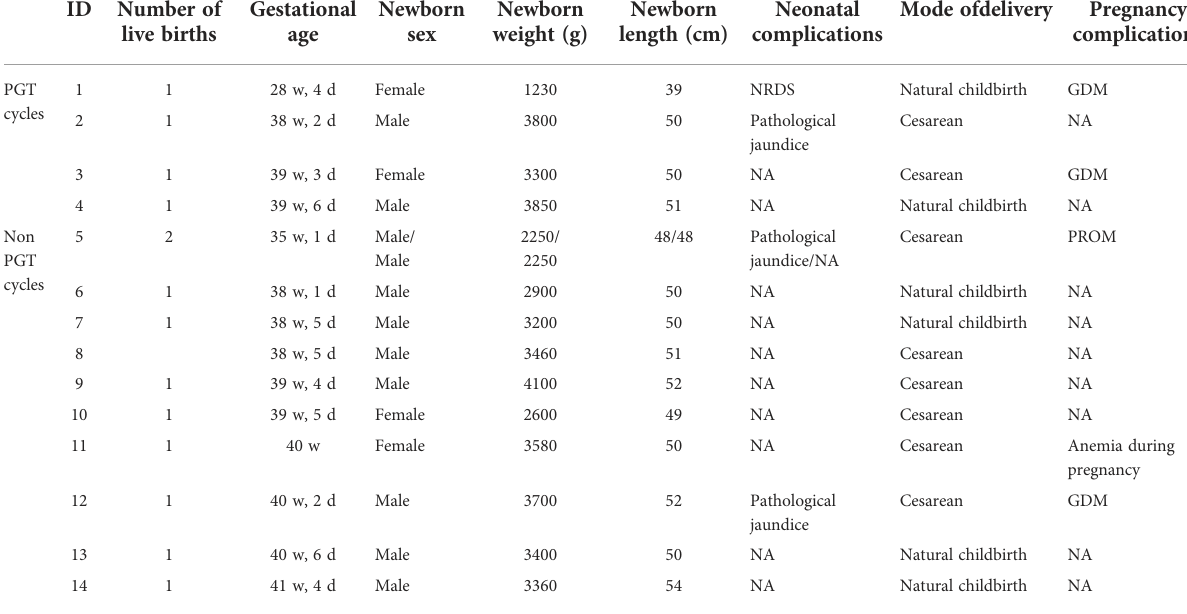
TABLE 5 General conditions of live-born neonates and maternal complications during pregnancy after D7 transfer (including PGT